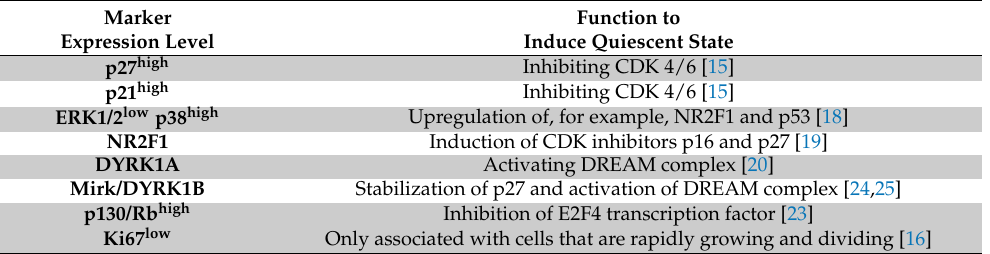
Function to Induce Quiescent State